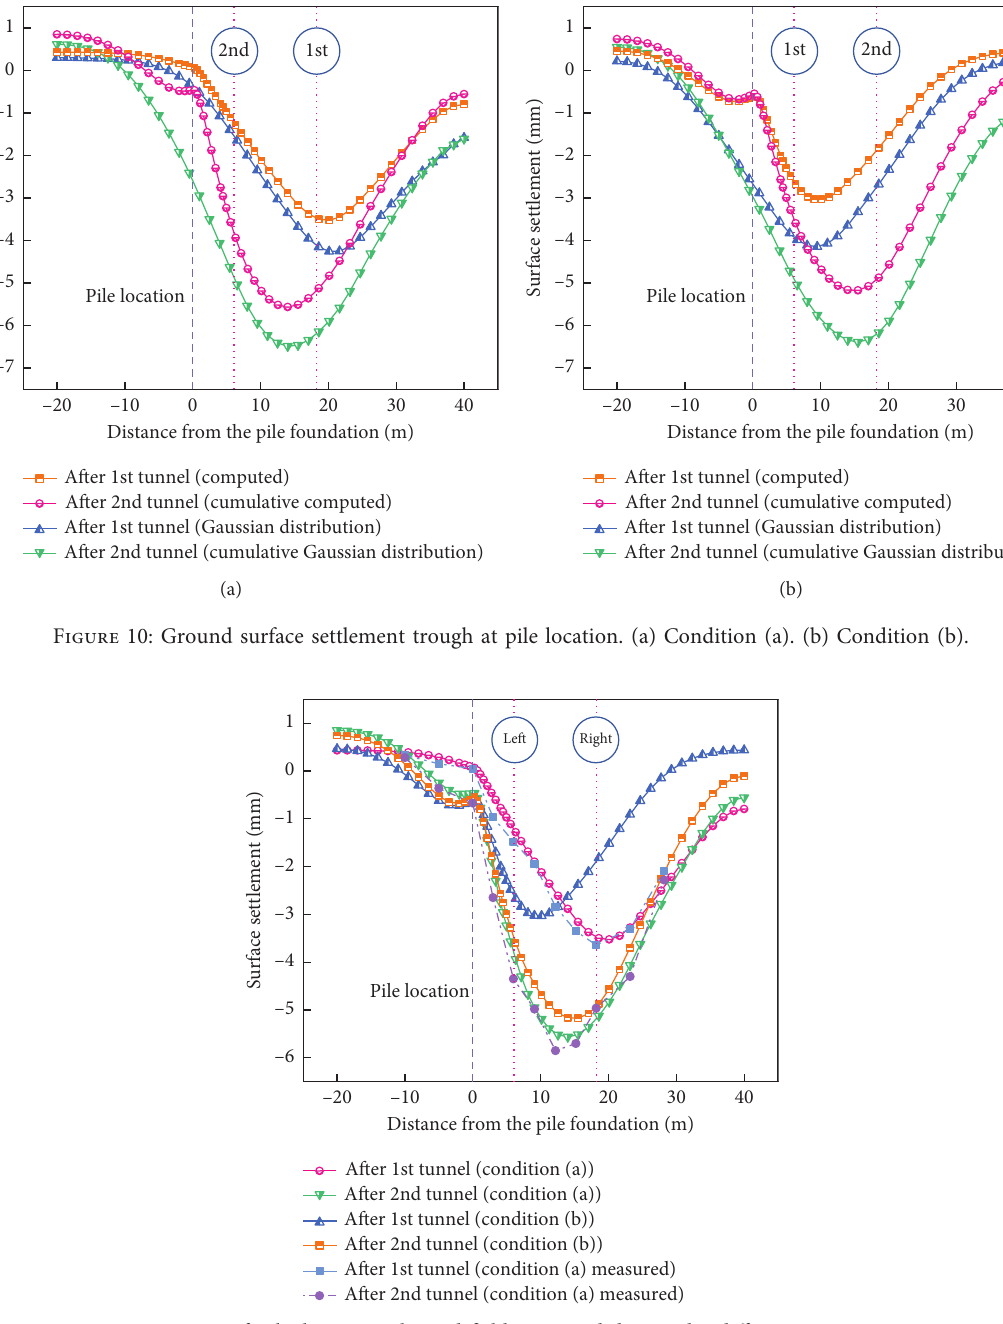
Figure 11: Comparison of calculation results and field measured data under different construction